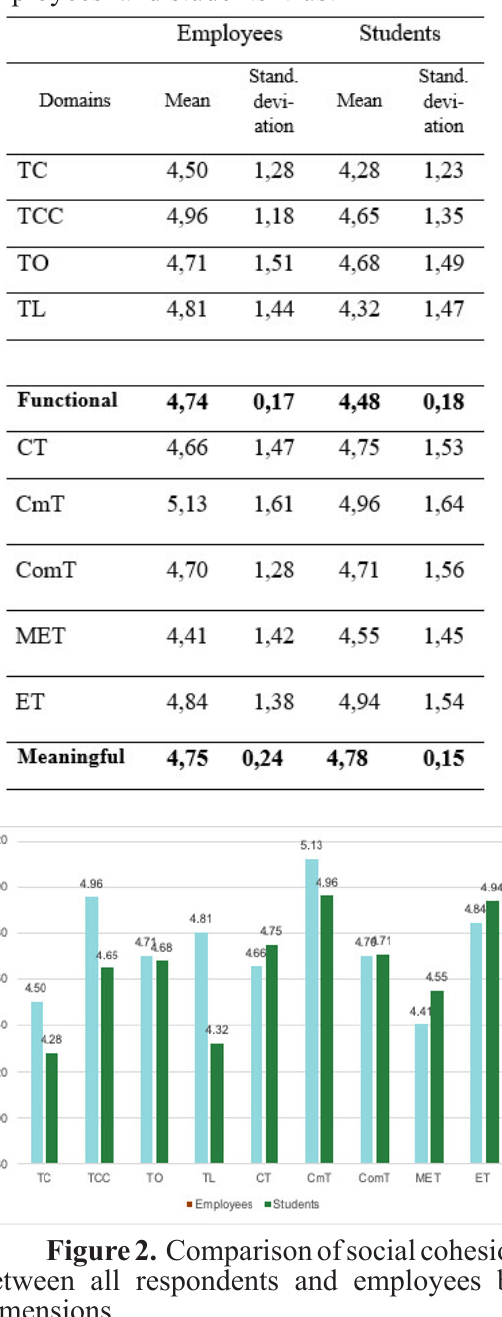
Table 3. Results of the evaluation of the